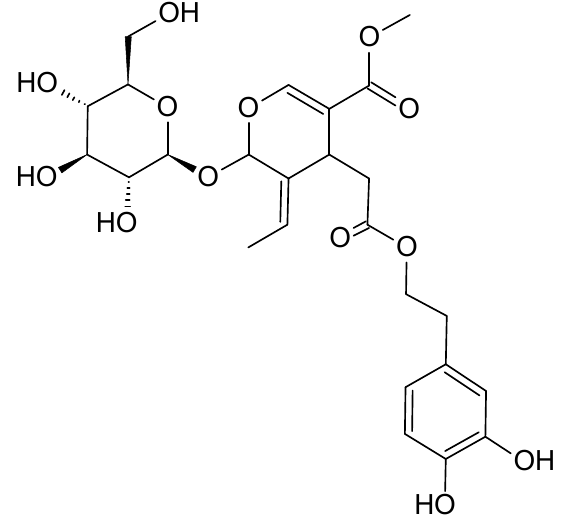
Figure 12. The structure of